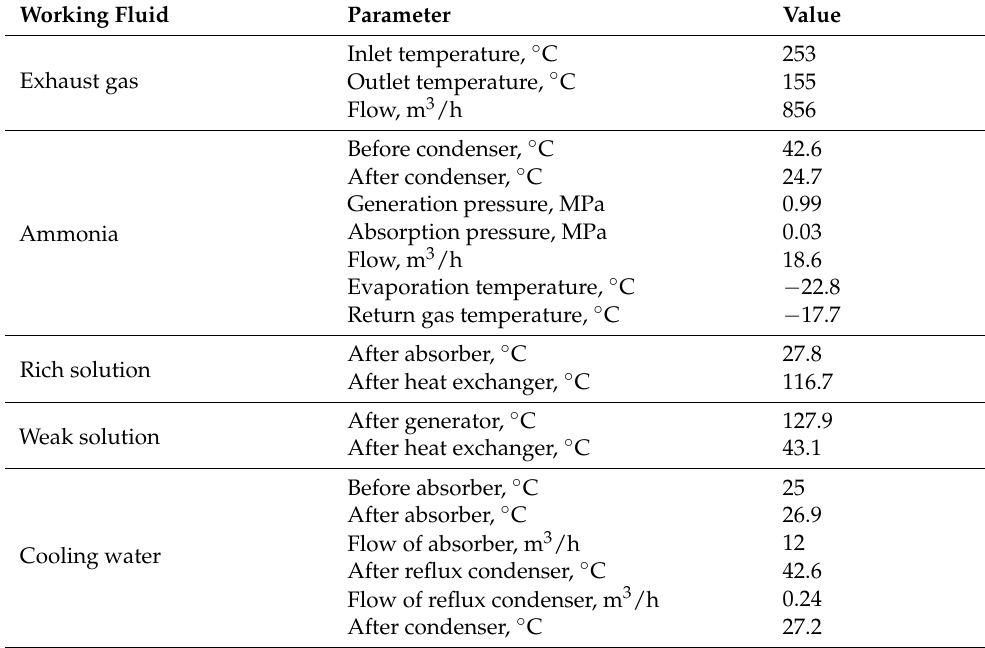
Table 1. Experimental performance of the refrigeration system.